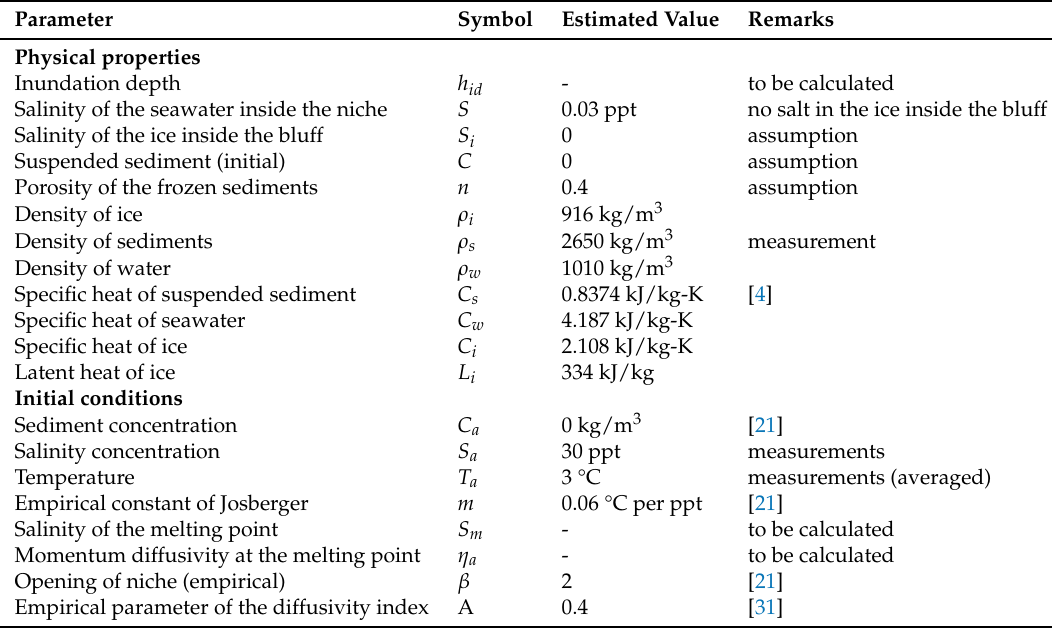
Table 1. Input parameters for the niche growth